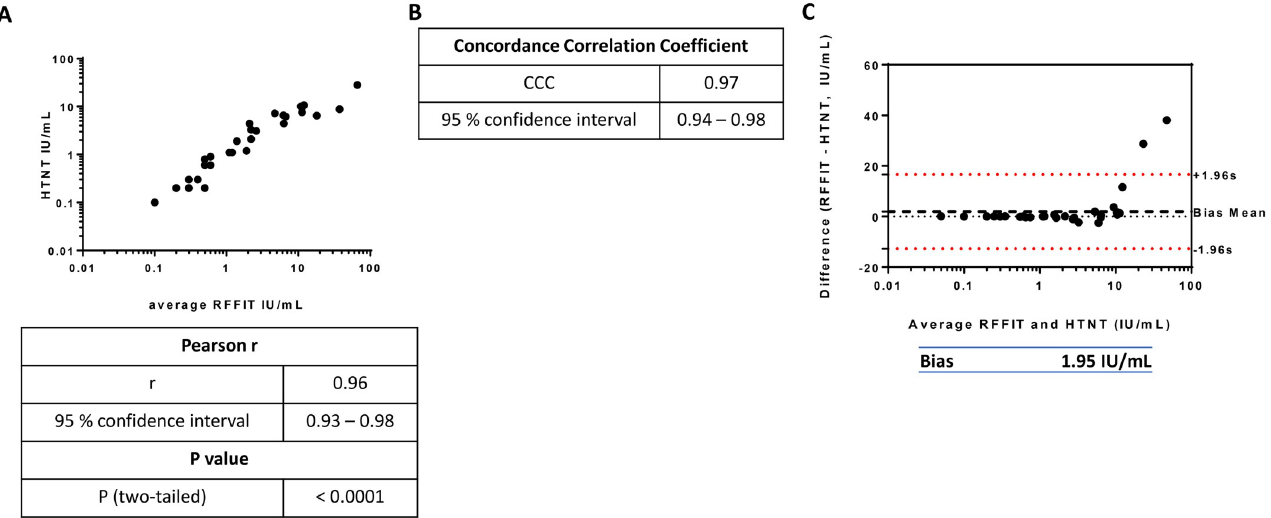
Fig 6. Comparison of HTNT and RFFIT titers of animal sera. The statistical analysis of animal sera were performed similar to Fig 6. The Pierson correlation coefficient (A), concordance correlation coefficient (B) and the Bland-Altman plot to determine bias value of titers (IU/ml) of positive animal sera (C) are provided. In (C) the mean difference of the titers is represented by the Bias value, plotted as a black dotted line above 0. The limits of agreement, within which 95% of the differences between RFFIT and HTNT are denoted by the red dotted lines above and below 1.96 standard deviations of the mean difference.